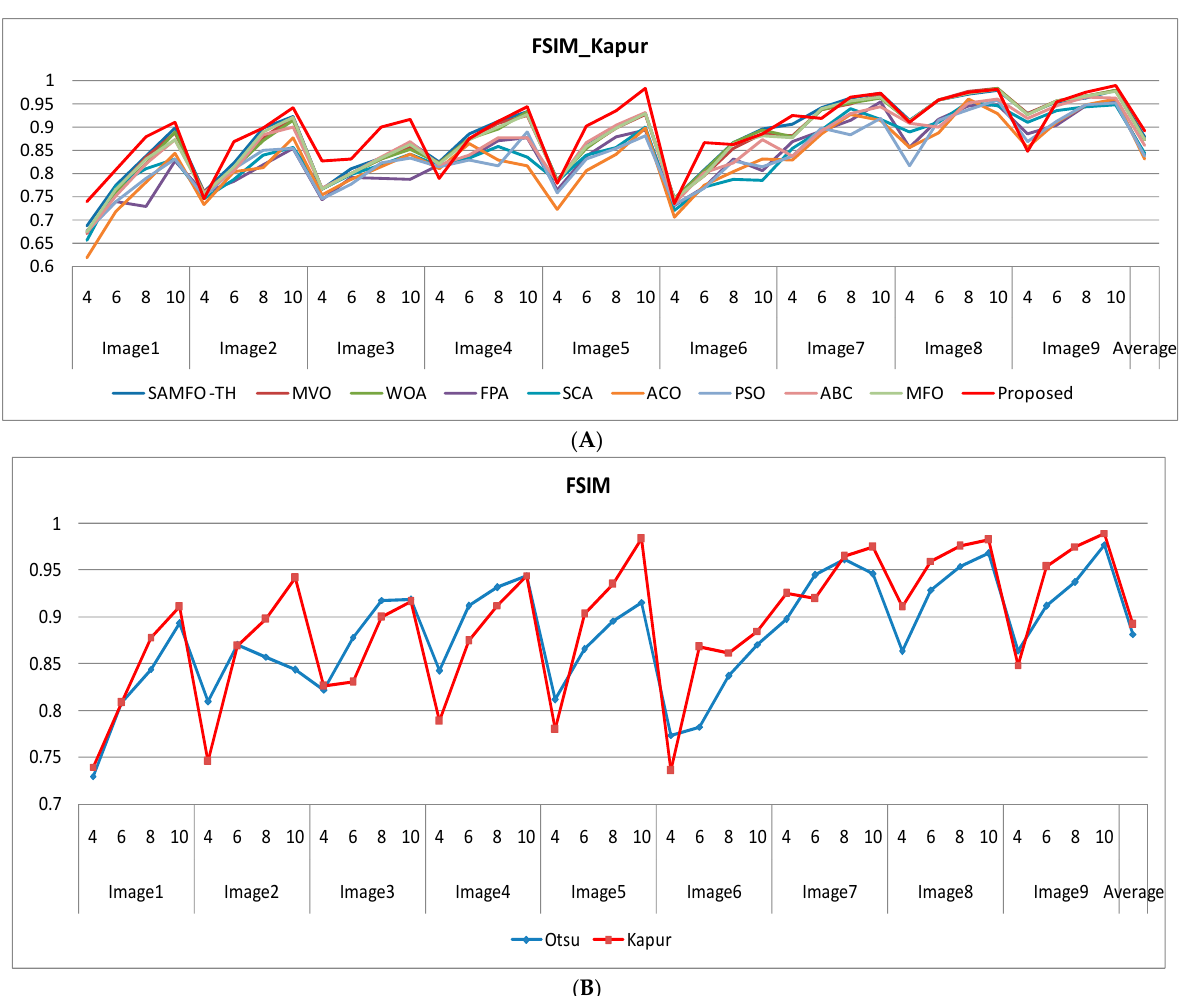
Figure 11. Comparison of SSIM with the proposed method based on Otsu’s and Kapur’s criteria.